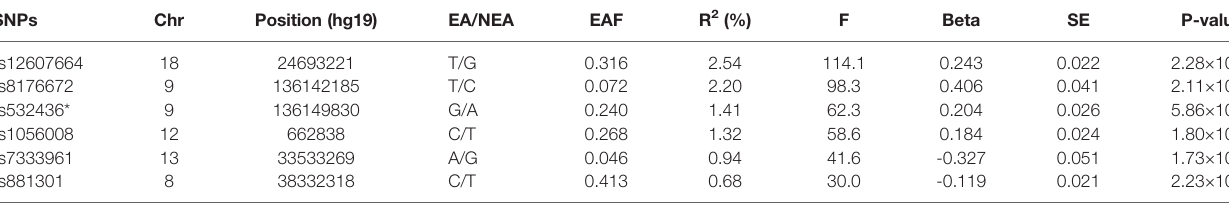
TABLE 1 | Information on instrumental SNPs associated with circulating a -Klotho